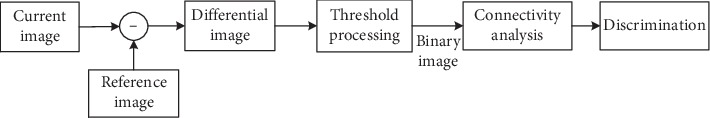
Flowchart of the background subtraction method.